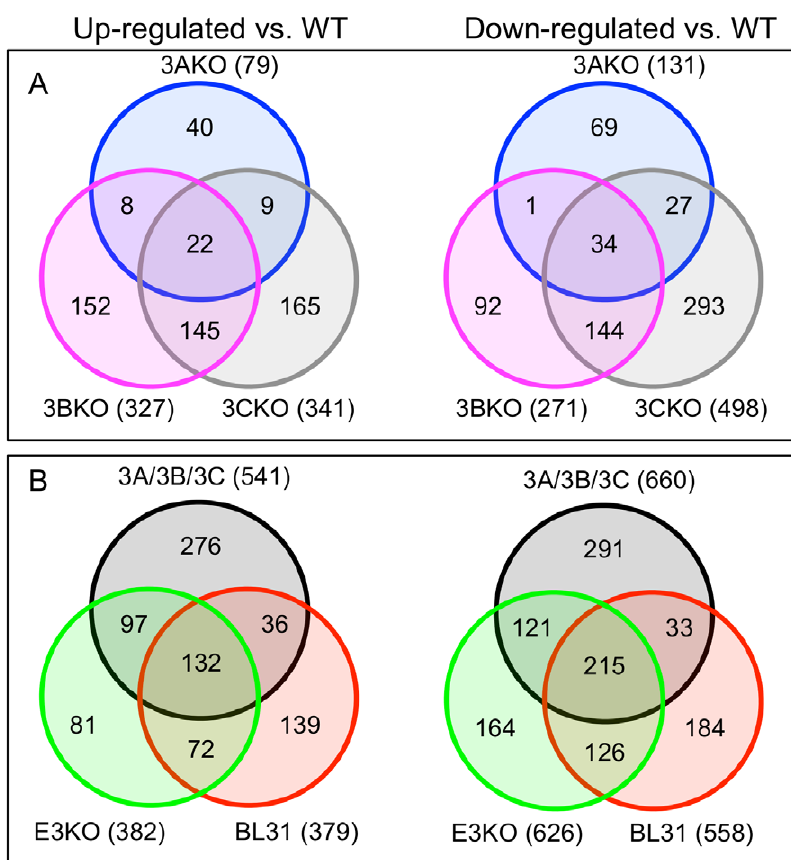
Figure 1. Overlap of genes differentially expressed by EBV mutant BL31 cells. Each set in the Venn diagram contains the number of genes defined as differentially regulated (p value , 0.001 and fold change . 2) for the mutant group shown as compared to wtBAC-infected BL31. The total number of genes in the set is indicated below the set’s identity. A. Numbers of genes differentially regulated in different combinations of EBNA3 knockout virus-infected BL31 cell lines are indicated. B. The combined group of genes falling in the venn diagrams from A (group 3A/3B/3C) is compared with genes differentially regulated between wtBAC-BL31s and E3KO-BL31s (bottom left set) or uninfected BL31 (bottom right set). Up- regulated vs WT (left side Venn diagrams) indicates genes whose expression was higher in the mutant-infected/uninfected BL31s than wtBAC- infected BL31s; down-regulated vs WT indicates lower expression in these lines.